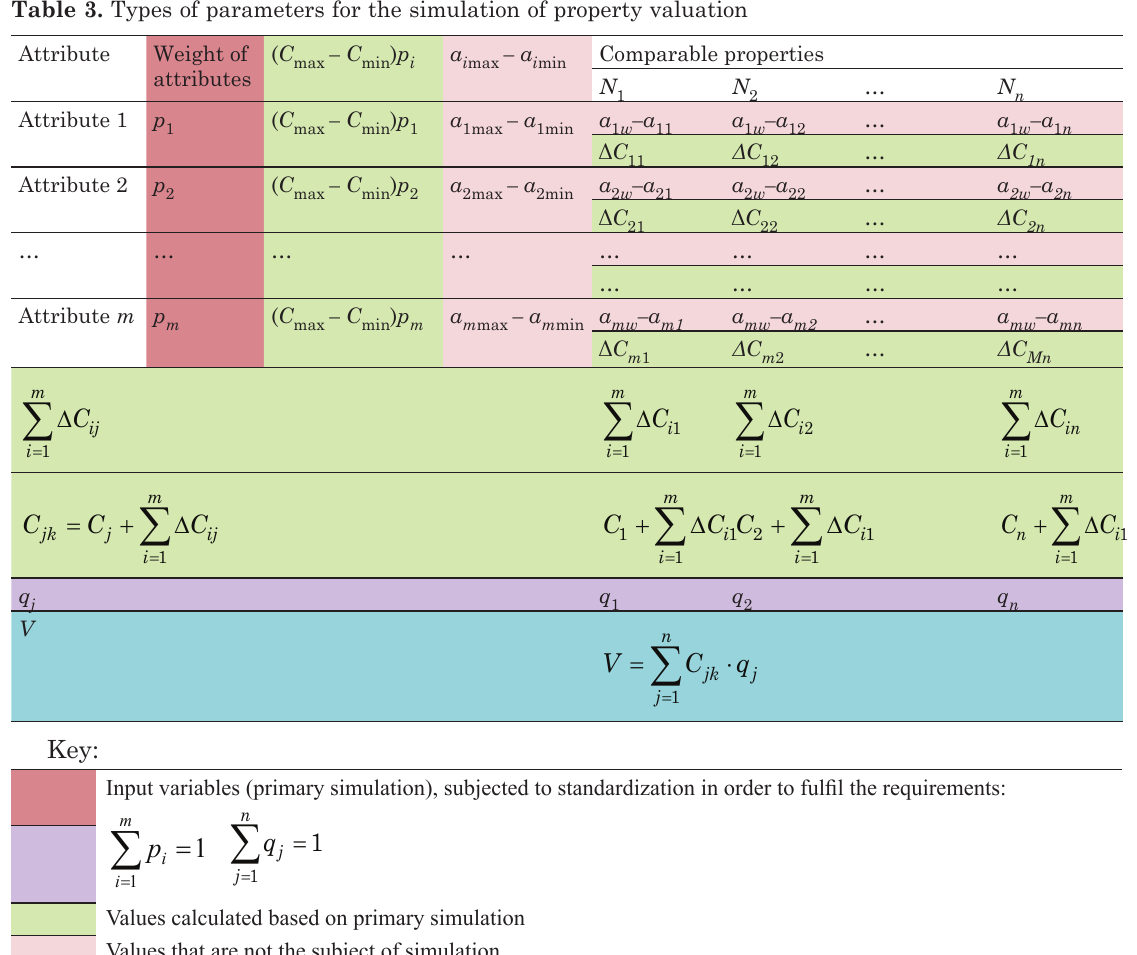
Figure 1. Demonstrative presentation of property value as a result of a simulation